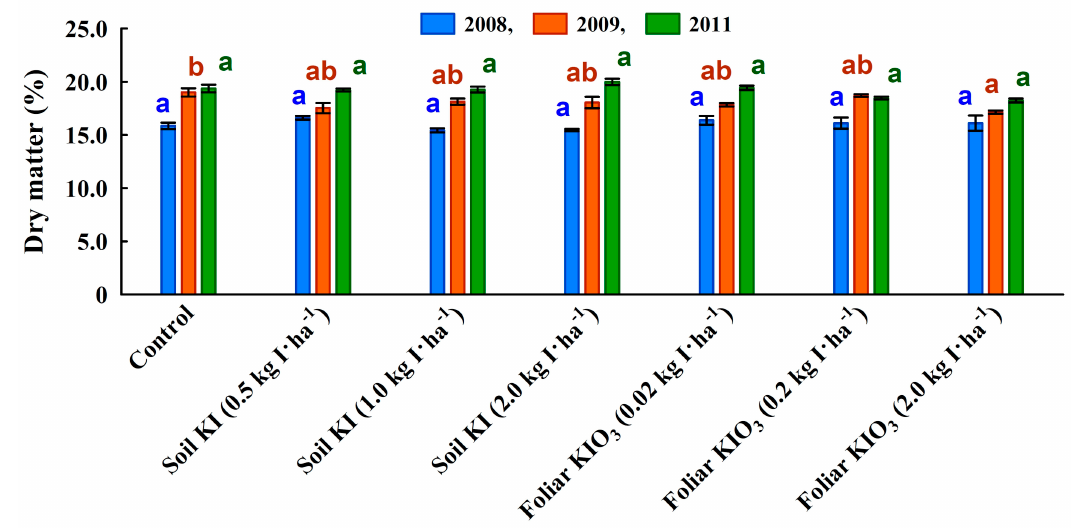
Figure 1. Dry matter content in potato tubers in individual years the study; values followed by the same letters within an individual year are not statistically different at p < 0.05, ( n = 4).